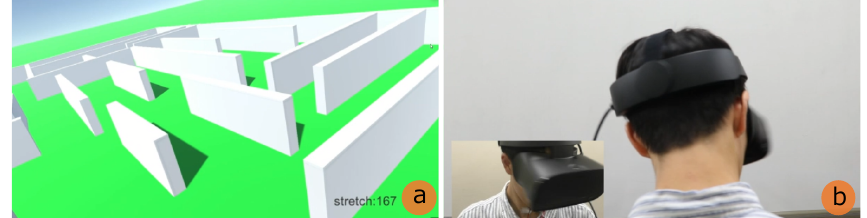
Figure 9. VR maze ( a : user’s view field; b : user) (the user’s view is first-person perspective).